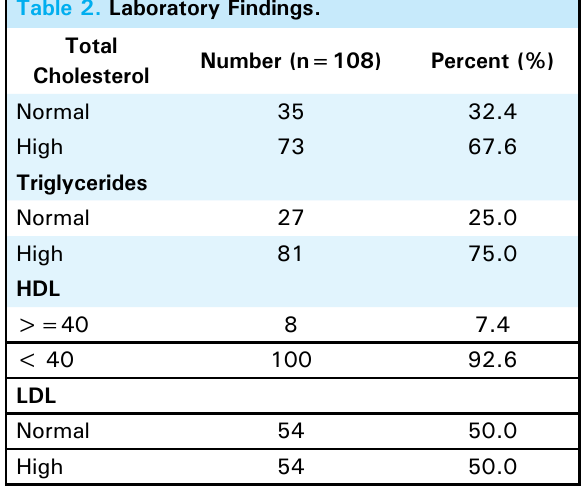
table 2. laboratory Findings.